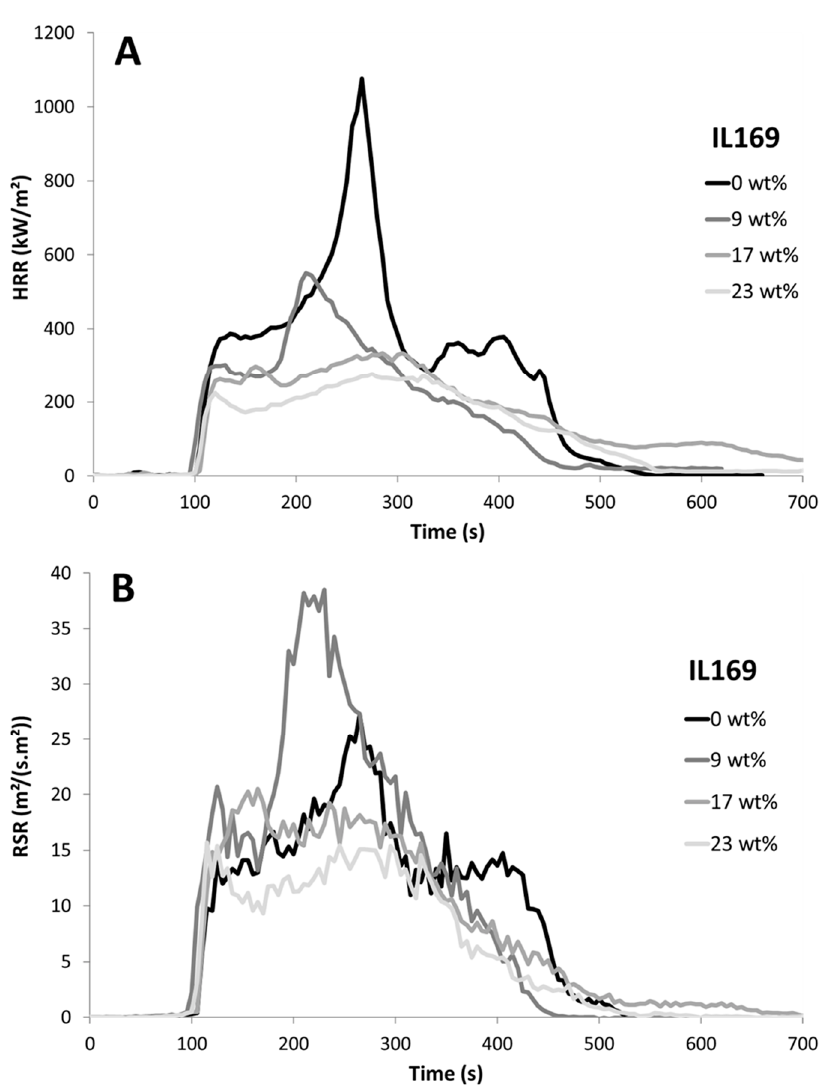
Figure 3. ( A )/HRR versus time in cone calorimeter (35 kW/m 2 ) for epoxy resin filled with various contents of IL169. ( B )/RSR versus time in cone calorimeter (35 kW/m 2 ) for epoxy resin filled with